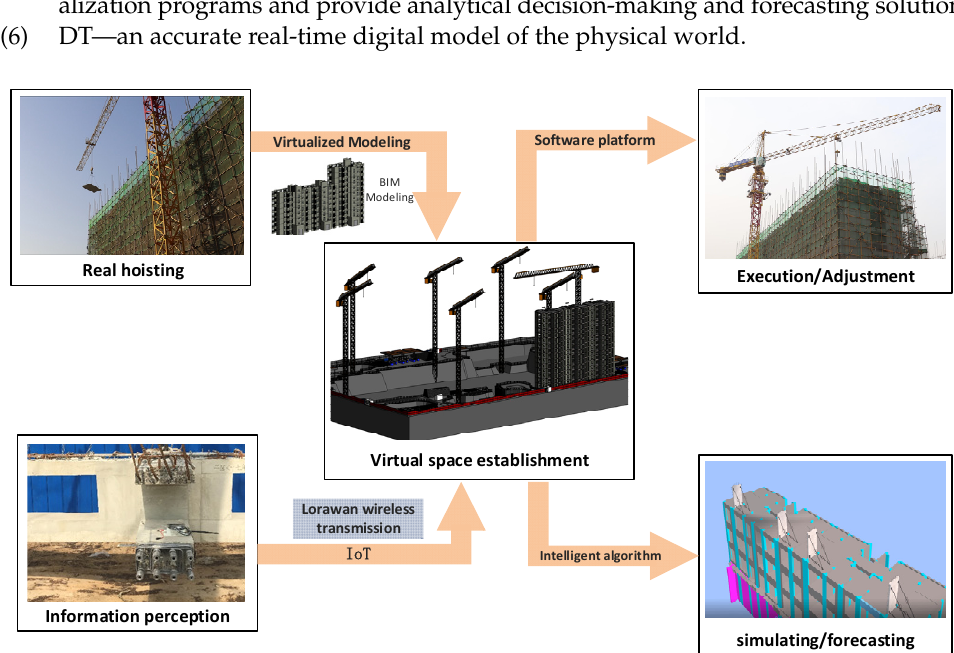
Figure 6. Twinning management method of hoisting of PCs.